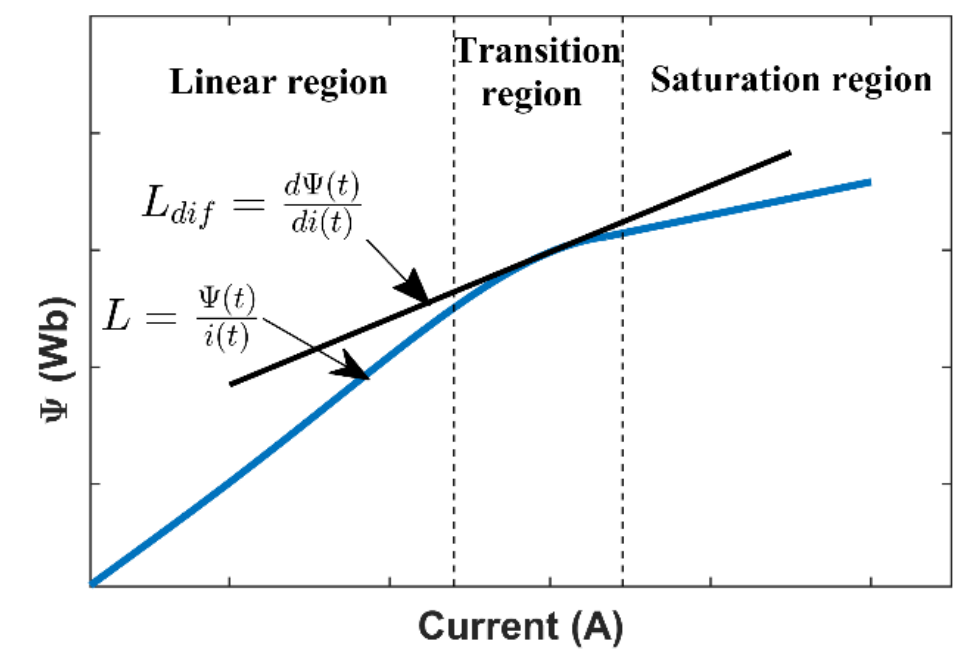
Figure 1. Typical magnetization characteristic of a core made of ferrite.